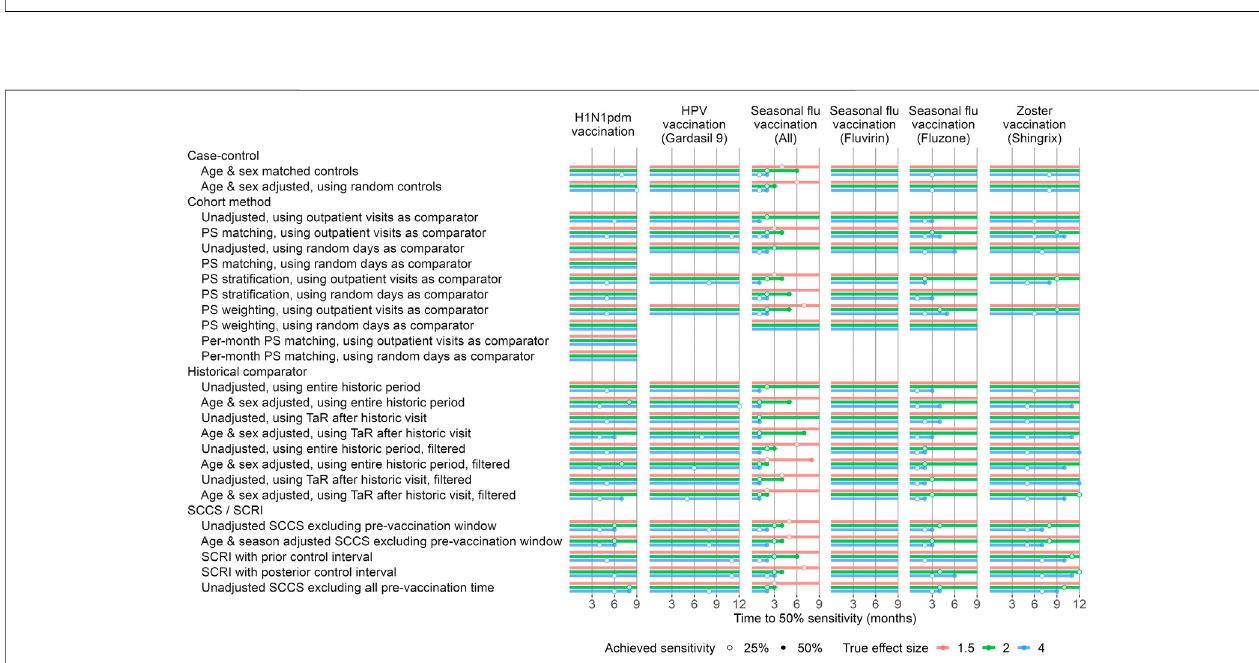
FIGURE5| Timeto50%sensitivityaftercalibration.Foreachmethodvariationandvaccinegroup,thenumberofmonthsofdataneededtoachieve50%sensitivity based on the calibrated MaxSPRT in the Optum EHR database are shown, strati fi ed by true effect size of the positive controls. HPV = Human papillomavirus, PS = Propensity Score, SCCS = Self-Controlled Case Series, SCRI = Self-Controlled Risk Interval, TaR = Time-at-Risk.